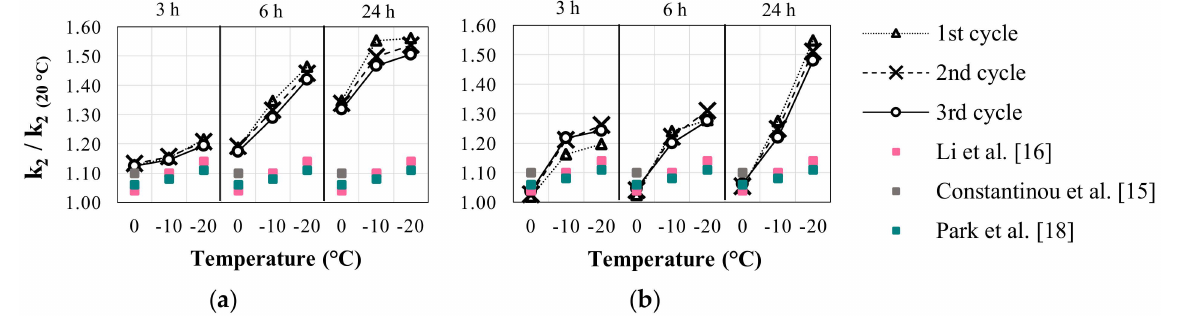
Figure 18. Comparison of amplifications in k 2 with the estimations of amplification factors in the literature for 0.5 Hz loading frequency at ( a ) 100% and ( b ) 134% shear